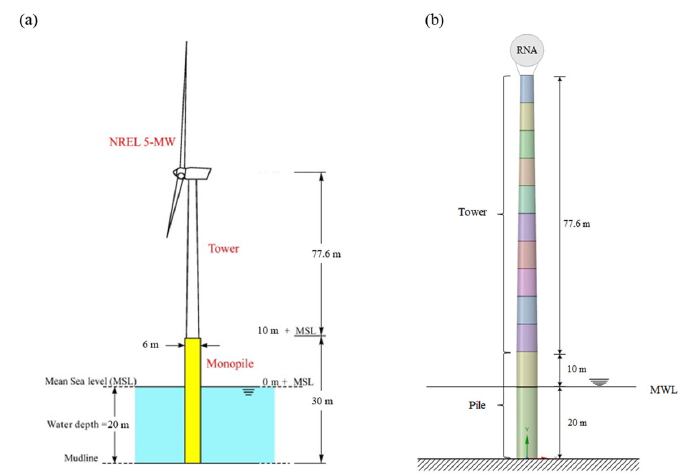
Figure 3. ( a ) The 5 MW offshore wind turbine (OWT) developed by NREL; ( b ) a simplified OWT model.